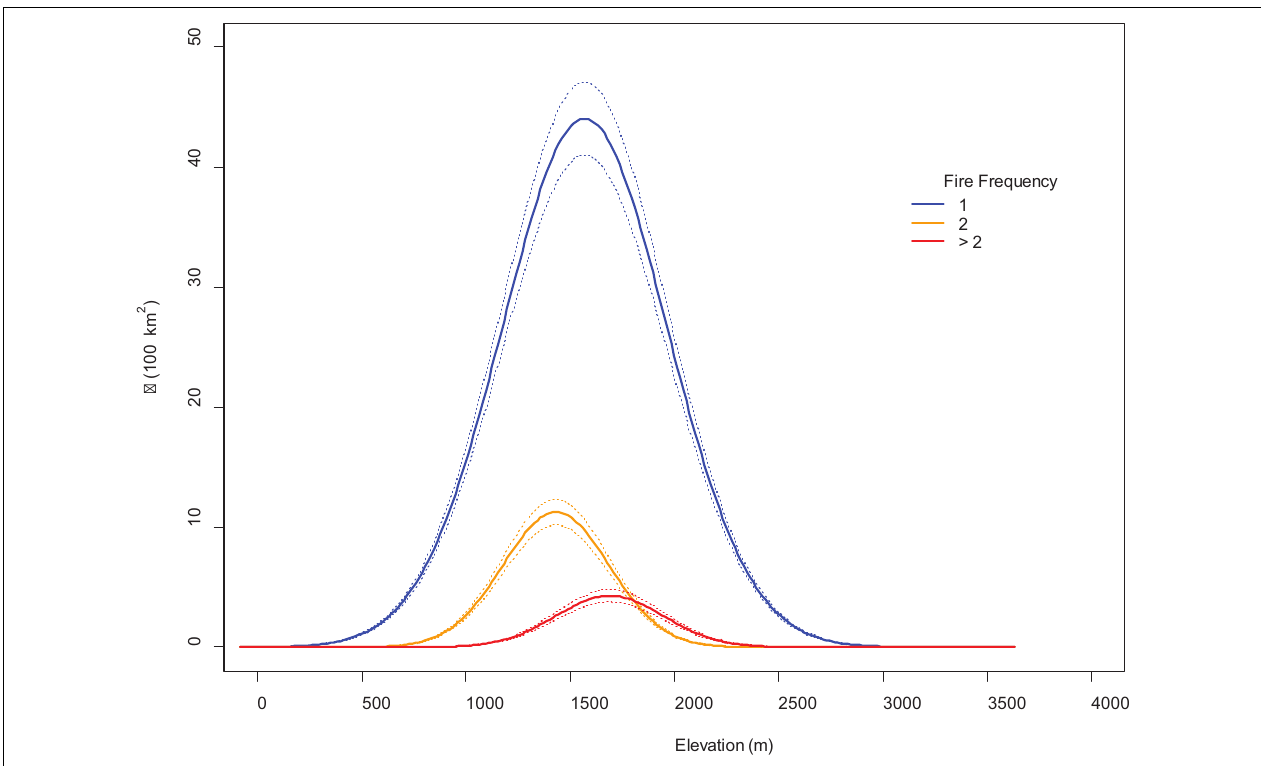
FIGURE 5 | Density ( λ ; ± 95% CIs) of pixels in three classes of fire frequency (number of times burned from 1972 to 2010) along an elevation gradient in the Mojave Desert of North America.